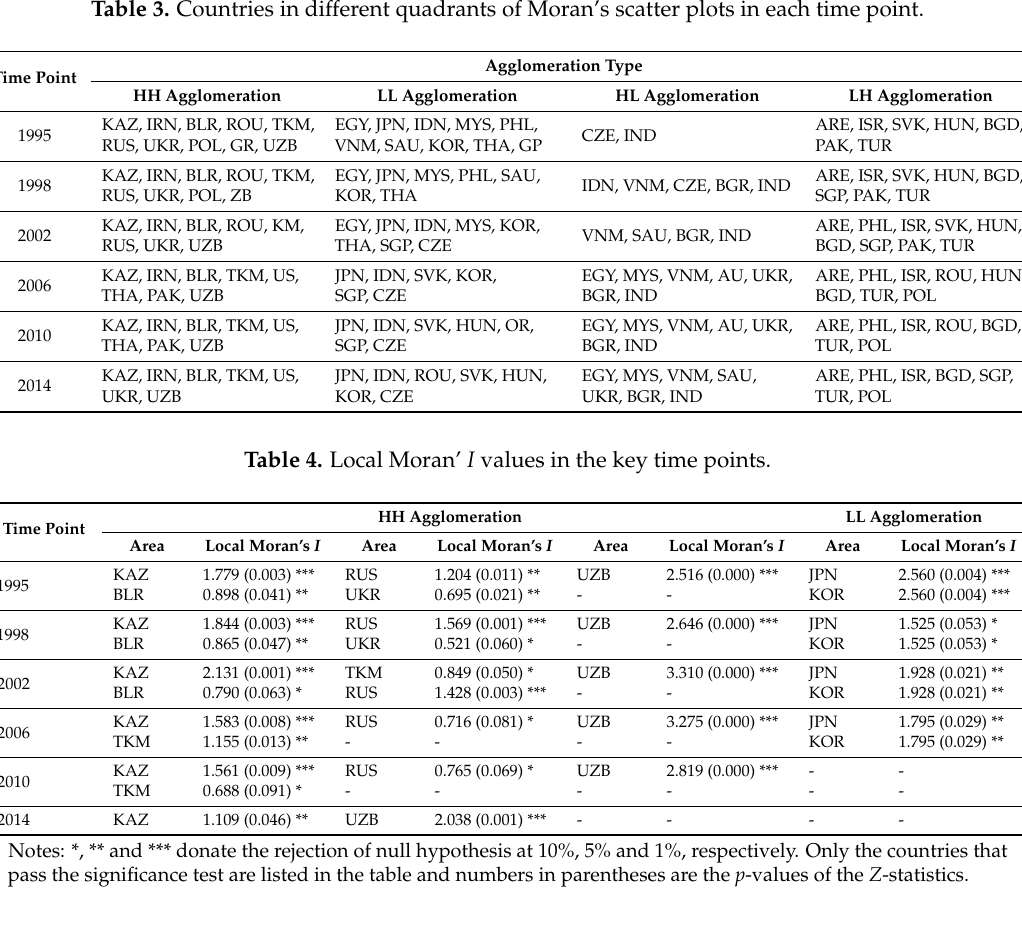
Table 3. Countries in different quadrants of Moran’s scatter plots in each time point.